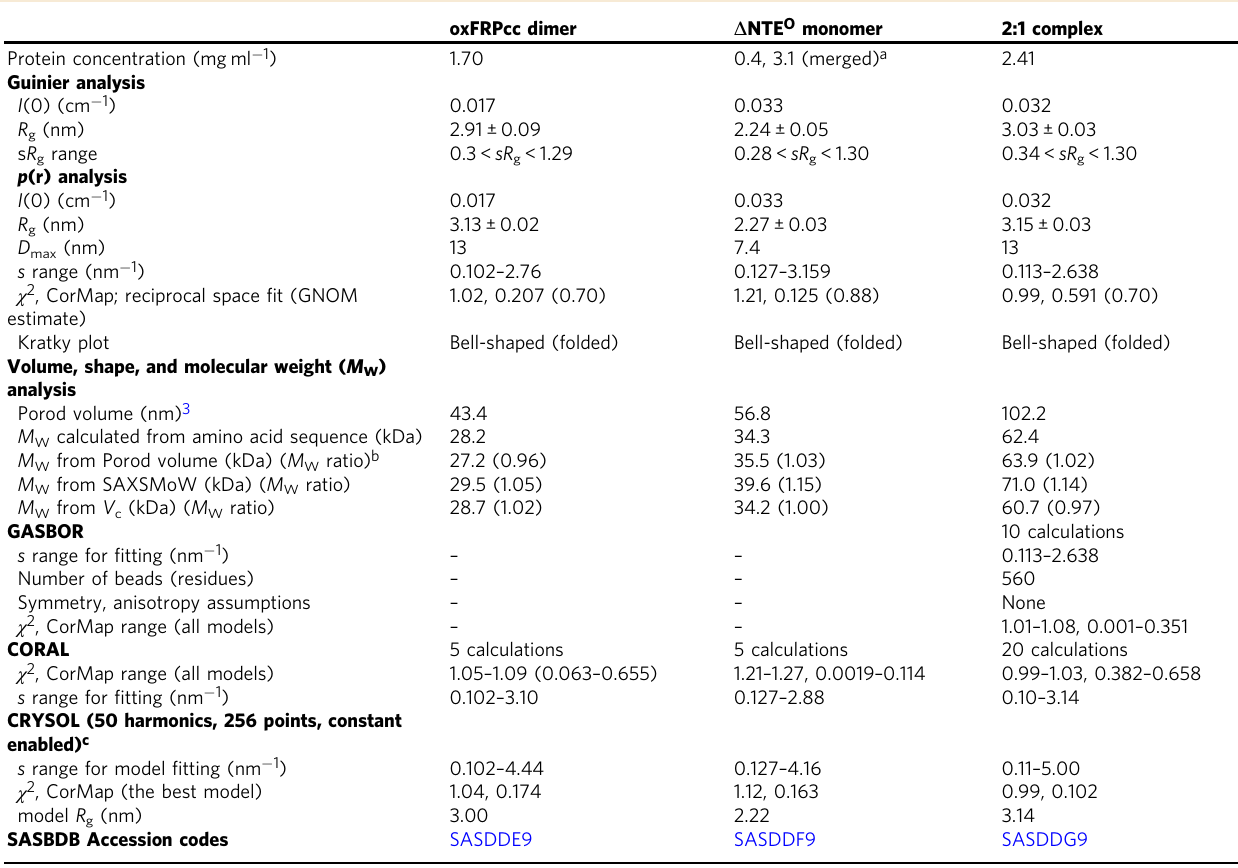
Table 2 Structural parameters for Δ NTE O , oxFRPcc, and their complex determined by SAXS oxFRPcc